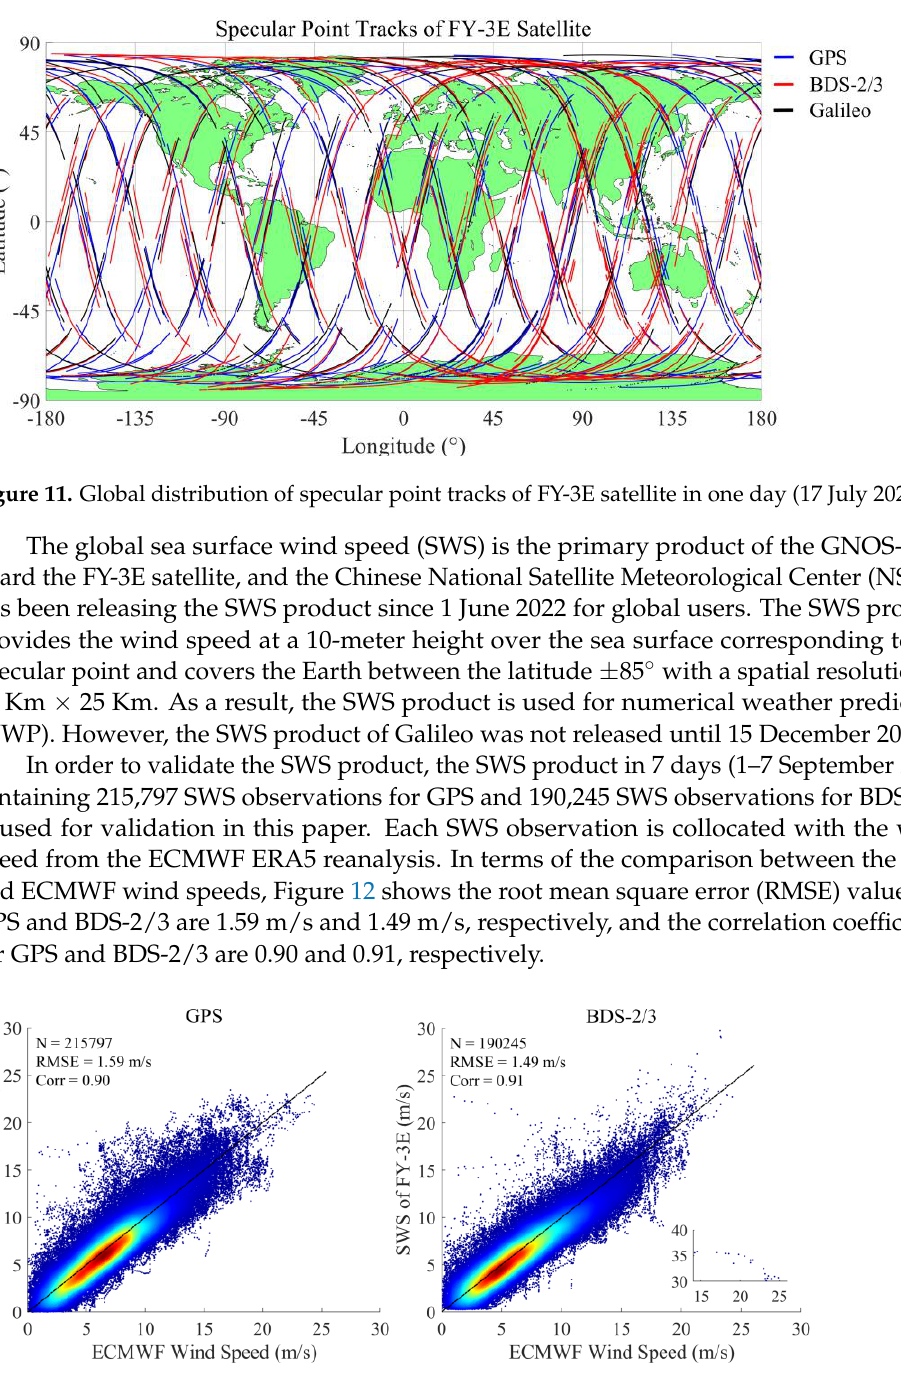
Figure 10. The number of tracks for each GNSS satellites from GPS (left), BDS-2/3 (middle), and Galileo (right) in one day (17 July 2022)